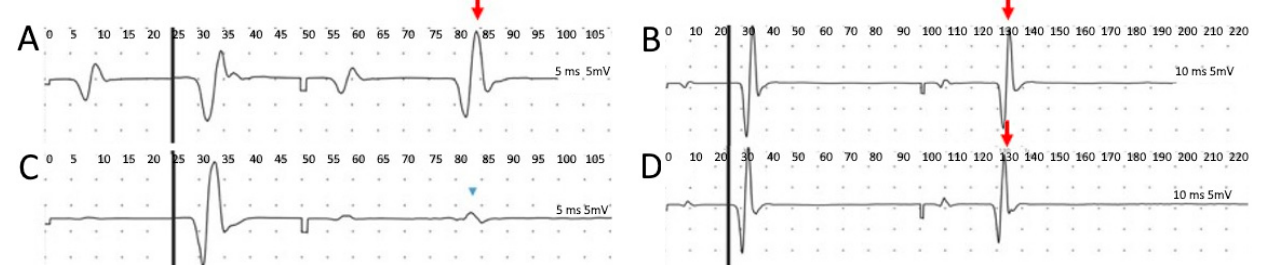
Table 3. Clinical and neurophysiological evidence of spinal cord modulating effects of TsMS.